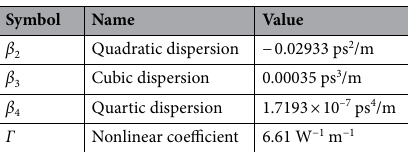
Table 1. Dispersion parameters for a waveguide width of 1500 nm and TM 10